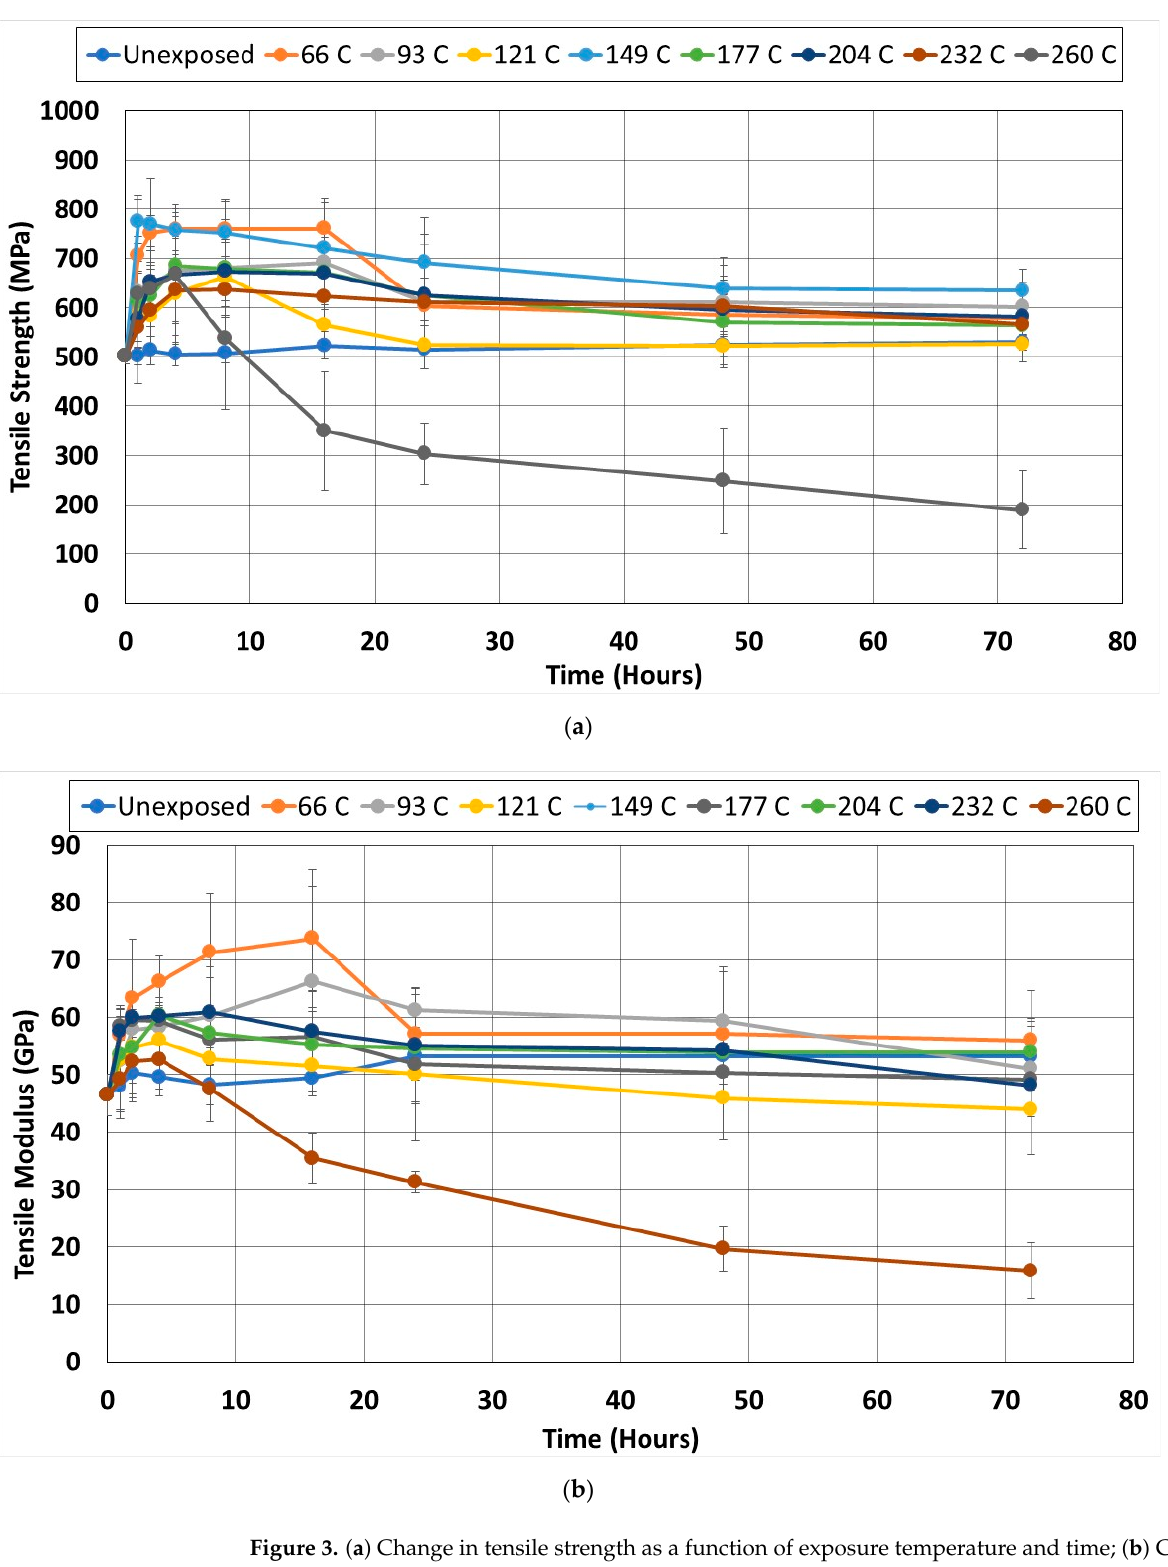
Figure 3. ( a ) Change in tensile strength as a function of exposure temperature and time; ( b ) Change in Tensile Modulus as a function of exposure temperature and time.